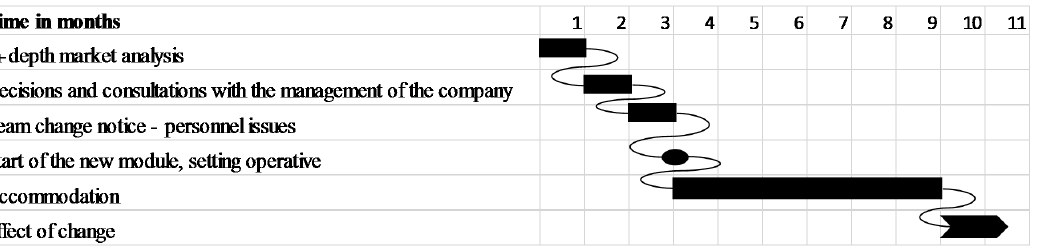
Figure 1. Gantt´s diagram. Figure 1. Gantt’s diagram.